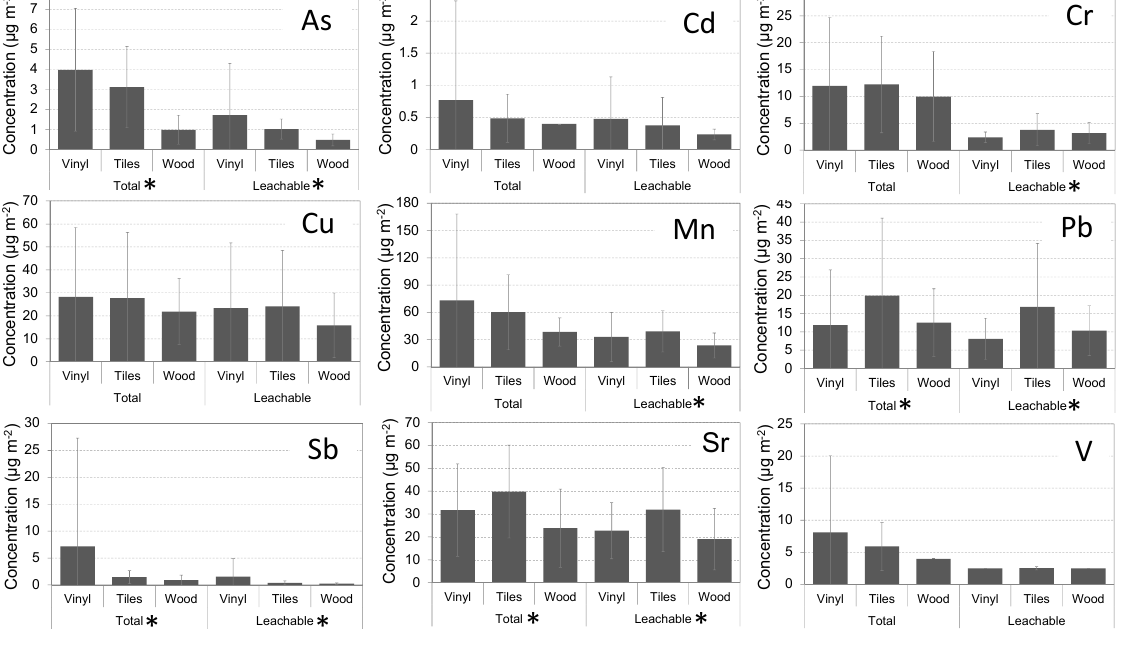
Figure 5. Mean metal loadings (total and leachable; μ g·m − 2 ) per classroom floor type. *: Denotes a significant difference within a group according to Kruskal-Wallis test results ( p -value <